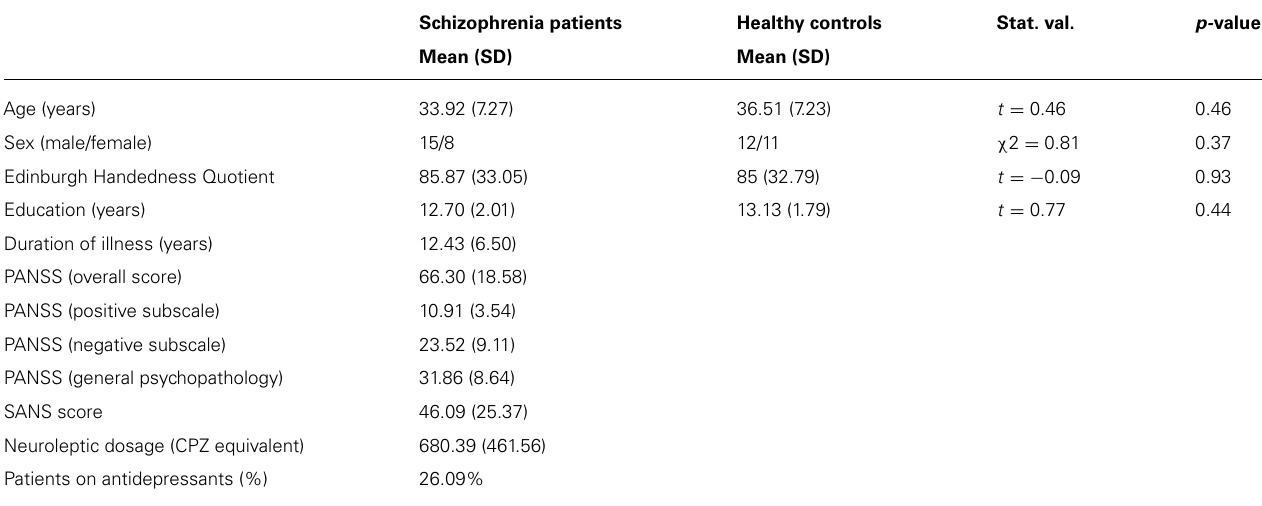
Table 1 | Clinical and demographic characteristics of patients with schizophrenia and healthy control participants.